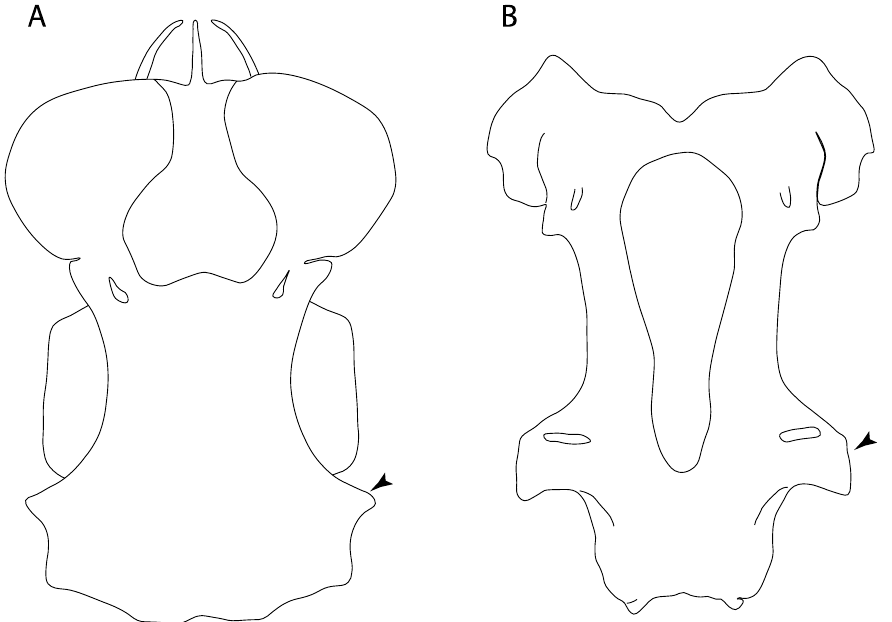
Figure 18. Interpretative drawings of the neurocranium in dorsal view. State (0): ( A ) Scyliorhinus cabofriensis (UERJ 2231.4) redrawn and modified from Soares et al. Text-Figure 7A in [88]. State (1): ( B ) Plesiobatis daviesi redrawn and modified from Nishida Text-Figure 10 in [82]. Arrowheads: post- orbital process.